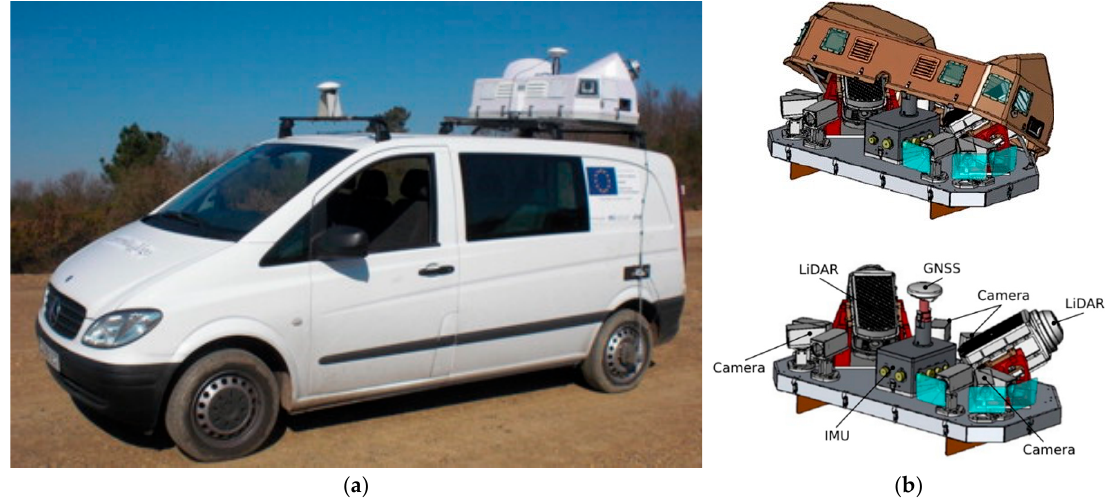
Figure 4. Optech Lynx mobile mapper used for the data collection: ( a ) vehicle; and ( b ) depiction of the system and the equipment installed on the vehicle [39].